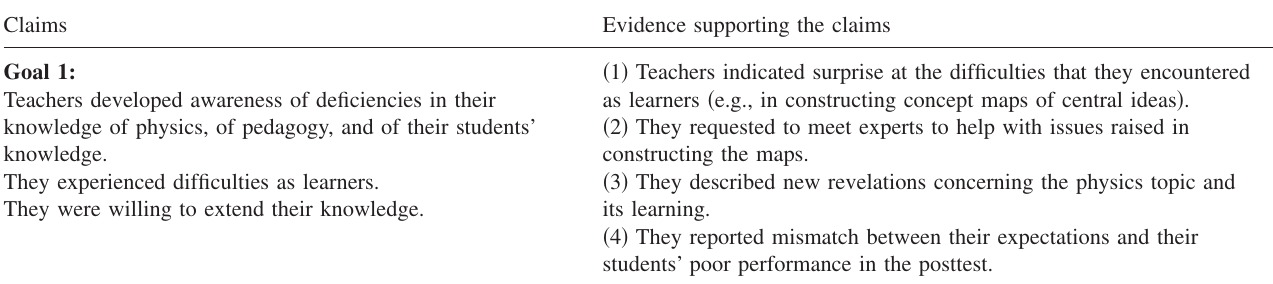
TABLE VII. Summary of claims and evidence for impact of the workshop. Claims Evidence supporting the